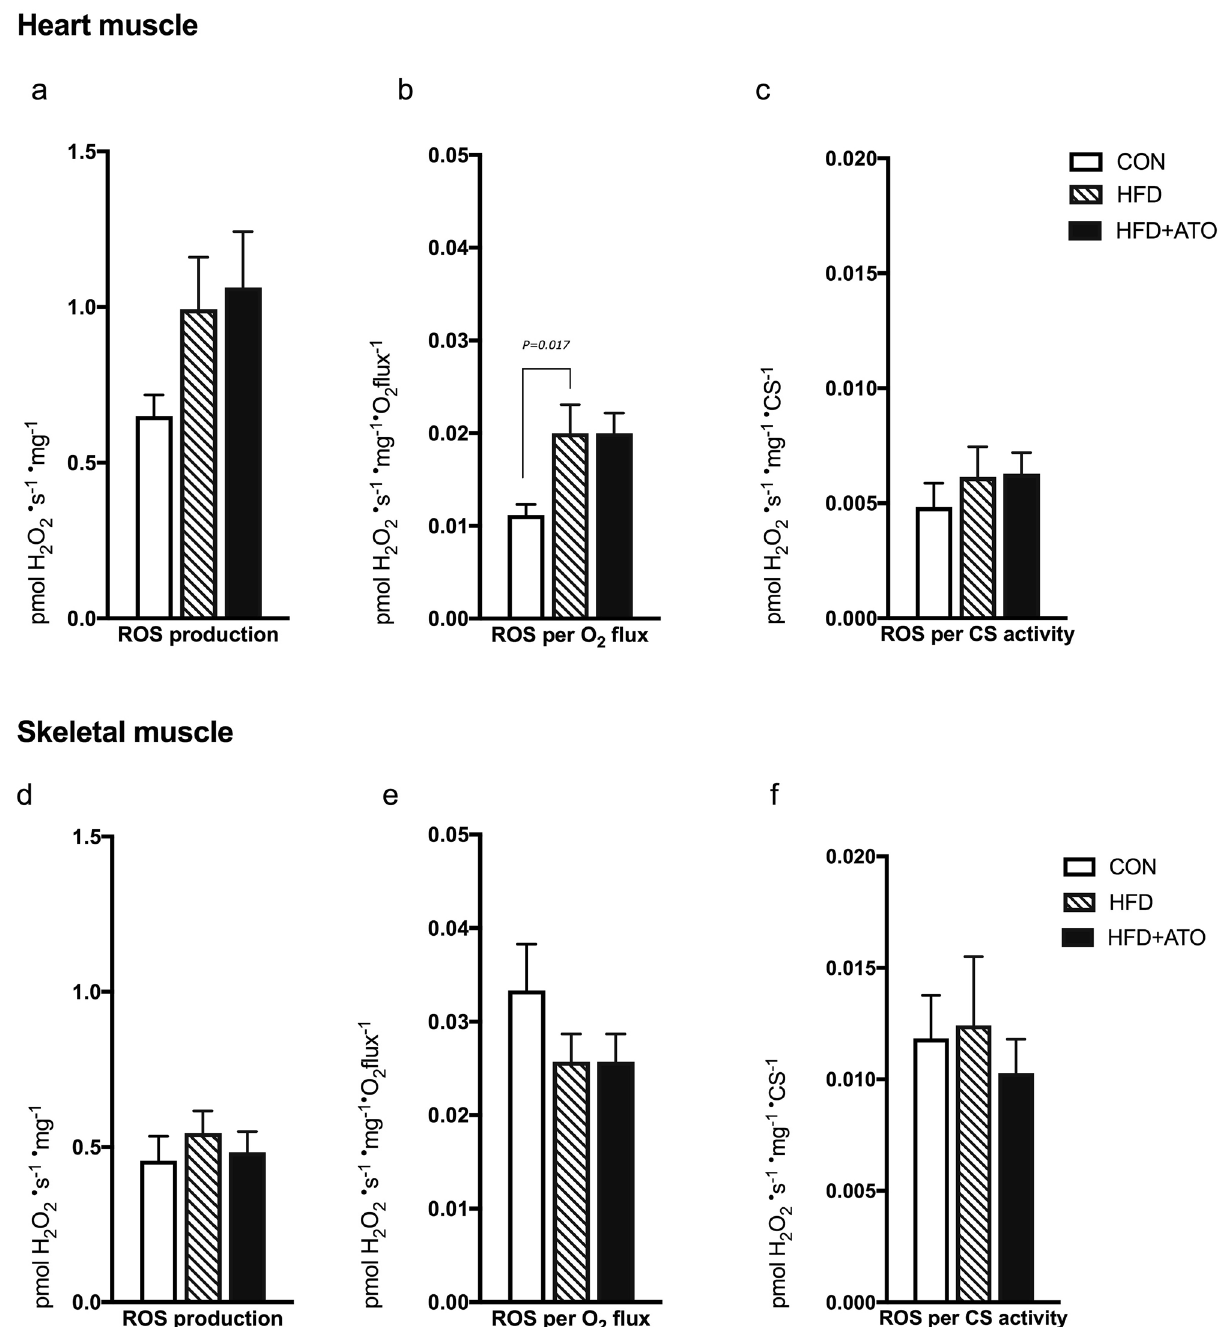
Figure 6. H 2 O 2 release in permeabilized heart muscle and skeletal muscle of obese and atorvastatin treated Göttingen Minipigs. ( a ). Absolute mass specific complex I + II (malate + glutamate + succinate) supported H 2 O 2 release (state 2 without addition of ADP) in permeabilized heart muscle fibers from lean control (CON), obese (HFD) and obese atorvastatin treated (HFD + ATO) Göttingen Minipigs. ( b ) H 2 O 2 release shown in A normalized to oxygen consumption (pmol/s/mg) in permeabilized heart muscle fibers. ( c ). H 2 O 2 release as shown in A normalized to mitochondrial content expressed as CS activity in permeabilized heart muscle fibers. ( d ) Absolute mass specific complex I + II supported H 2 O 2 release in permeabilized skeletal muscle fibers from lean control (CON), obese (HFD, n = 7) and obese atorvastatin treated (HFD + ATO) Göttingen Minipigs. ( e ) H 2 O 2 release as shown in D relative to O 2 flux in permeabilized skeletal muscle fibers. ( f ) H 2 O 2 release as shown in D normalized to mitochondrial content expressed as CS activity in permeabilized skeletal muscle fibers. CS citrate synthase. Data are means ± SEM, n = 6–7 in each